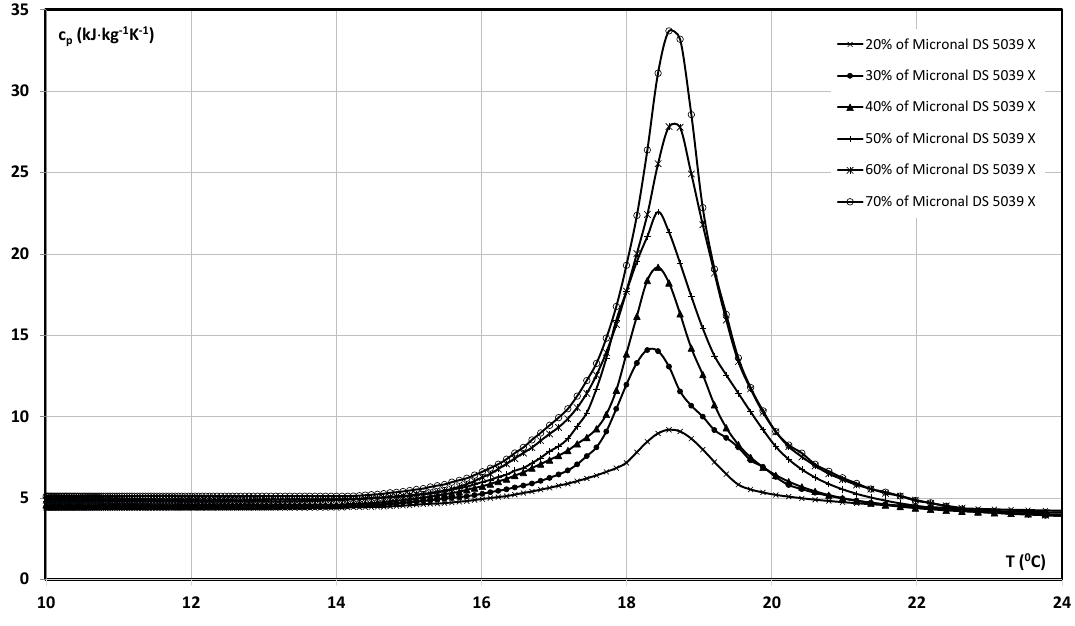
Figure 3. Evaluation of specific heat profiles for mPCM slurries vs. temperature.